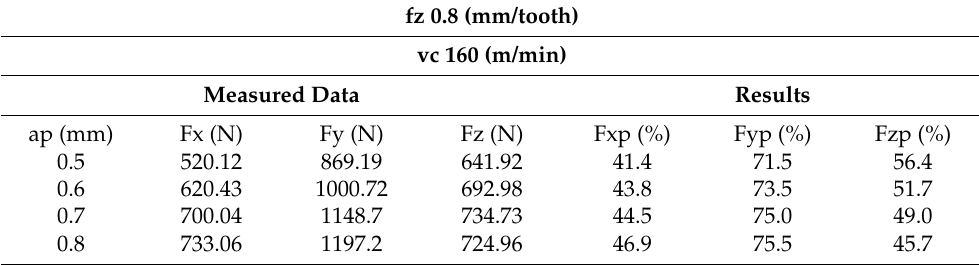
Table 12. Results for fz = 0.8 mm/tooth and vc = 160 m/min.